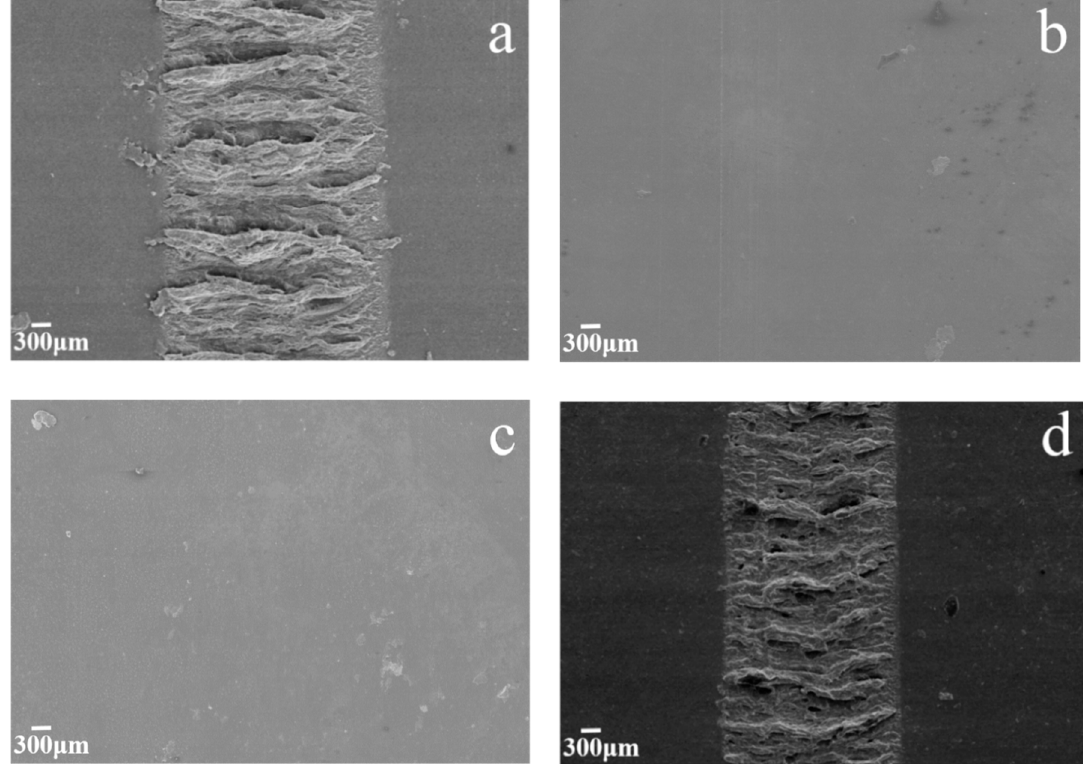
Figure 6. Micrographs of worn surface of MGO/WPU composite coating with different mass fractions of MGO, ( a ) 0.5 wt.%, ( b ) 1.0 wt.%, ( c ) 1.5 wt.%, ( d ) 3.5 wt.%.